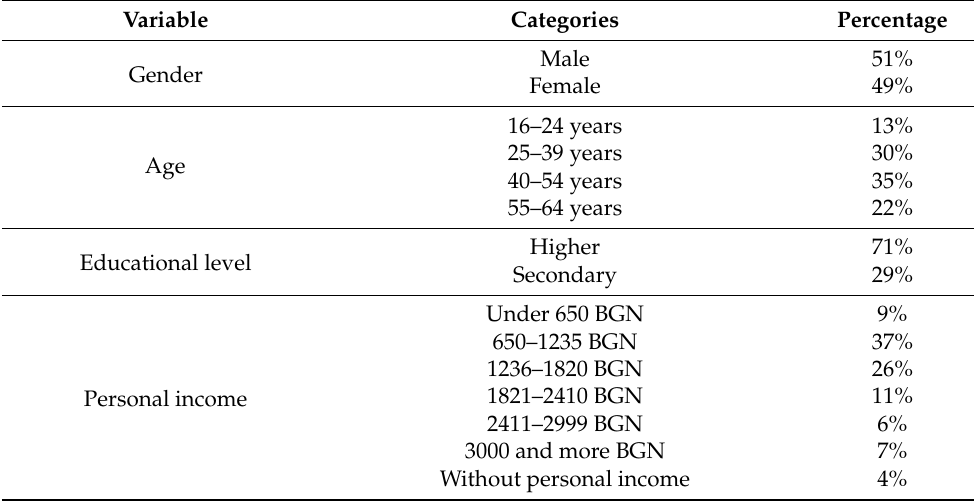
Table 4. Socio-demographic profile of the sample ( n =